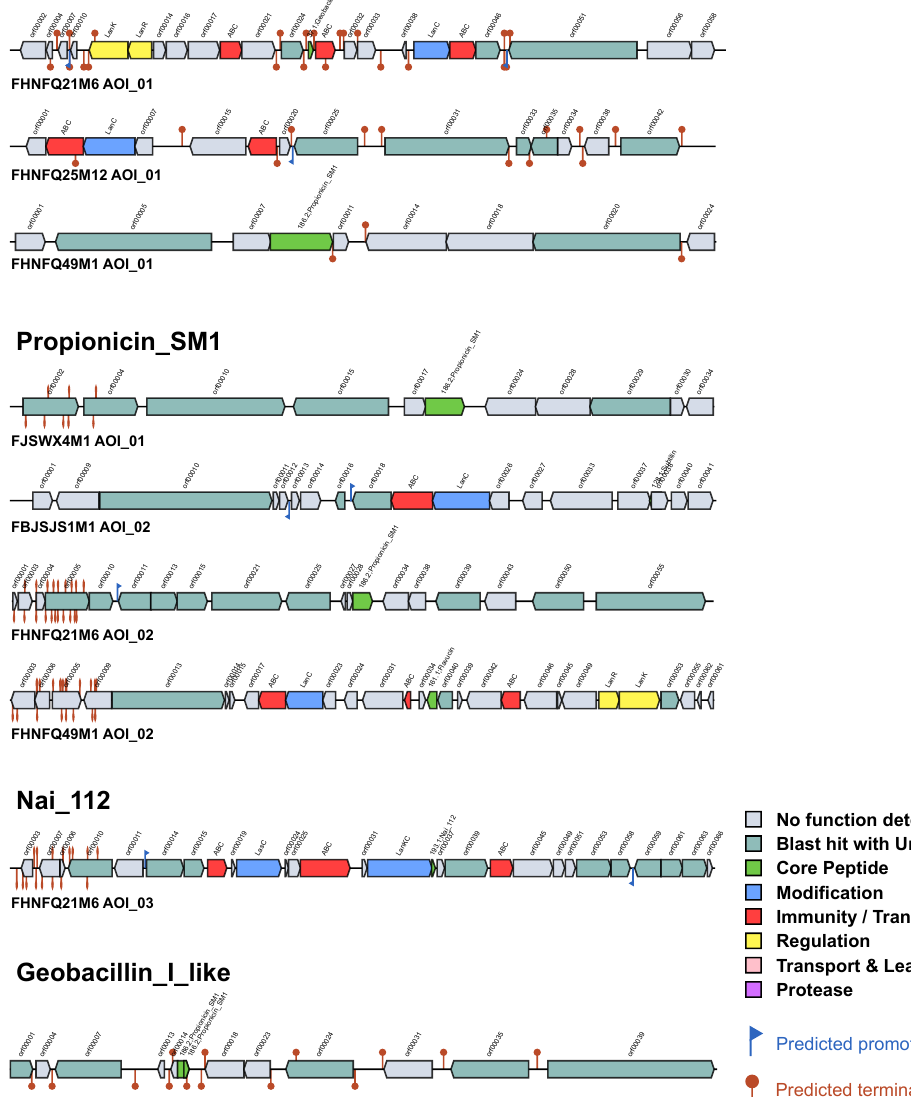
Figure 5. The potential bacteriocin operons identified in five B. bifidum